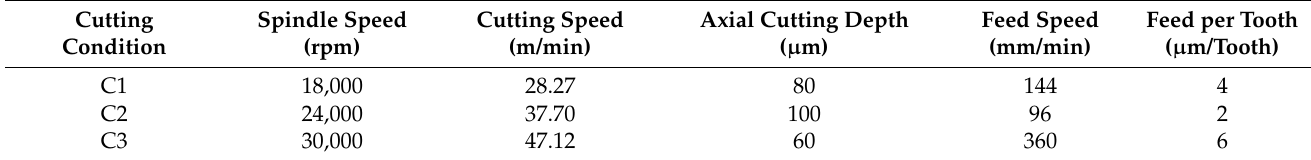
Table 2. Cutting conditions.